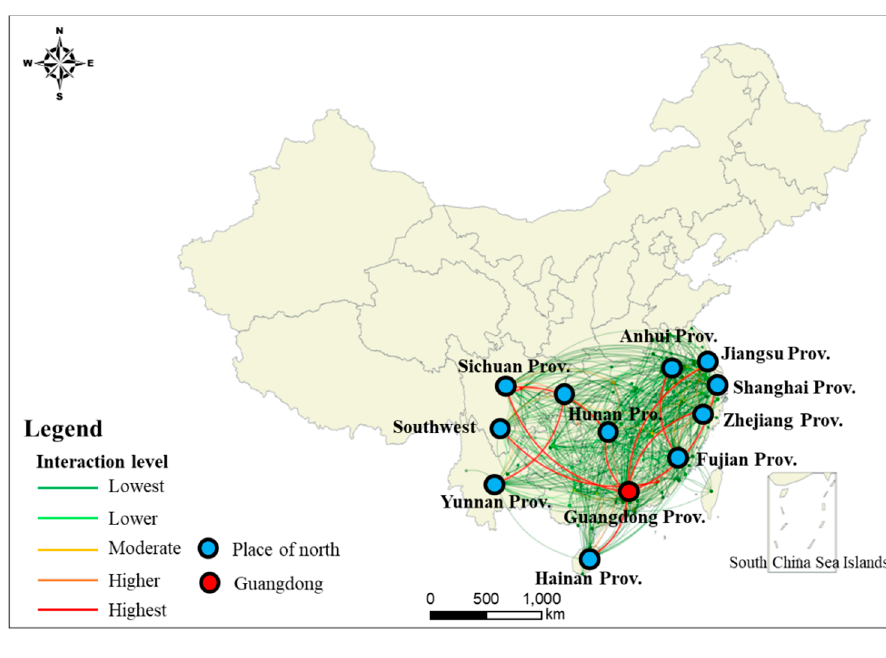
Figure 3 . Culture interaction flow pattern in China. Figure 3. Culture interaction flow pattern in